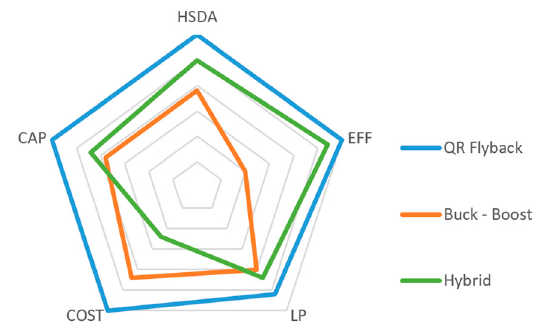
Figure 8. Performance of three main SS LED driver topologies: high step-down ability (HSDA), efficiency (EFF), reduced capacitor (CAP), cost (COST) and low power applications (LP).